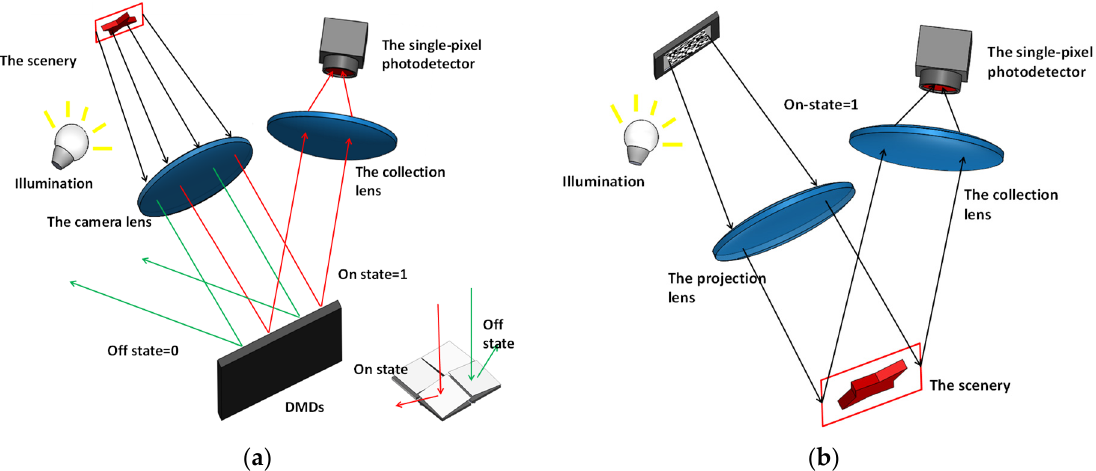
Figure 11. General architectures of two single-pixel imaging systems using digital micromirror devices (DMD): ( a ) the single-pixel camera architecture where the scenery is modulated at the focal plane with inset showing the DMD structure; ( b ) the computational ghost imaging architecture where the scenery is illuminated with the modulated light.